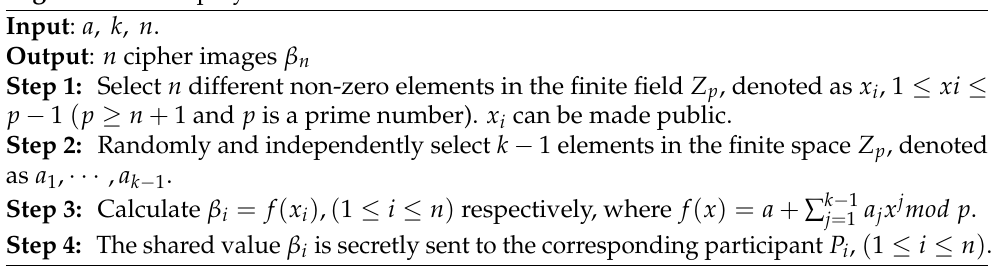
Algorithm 1 The polynomial-based SS